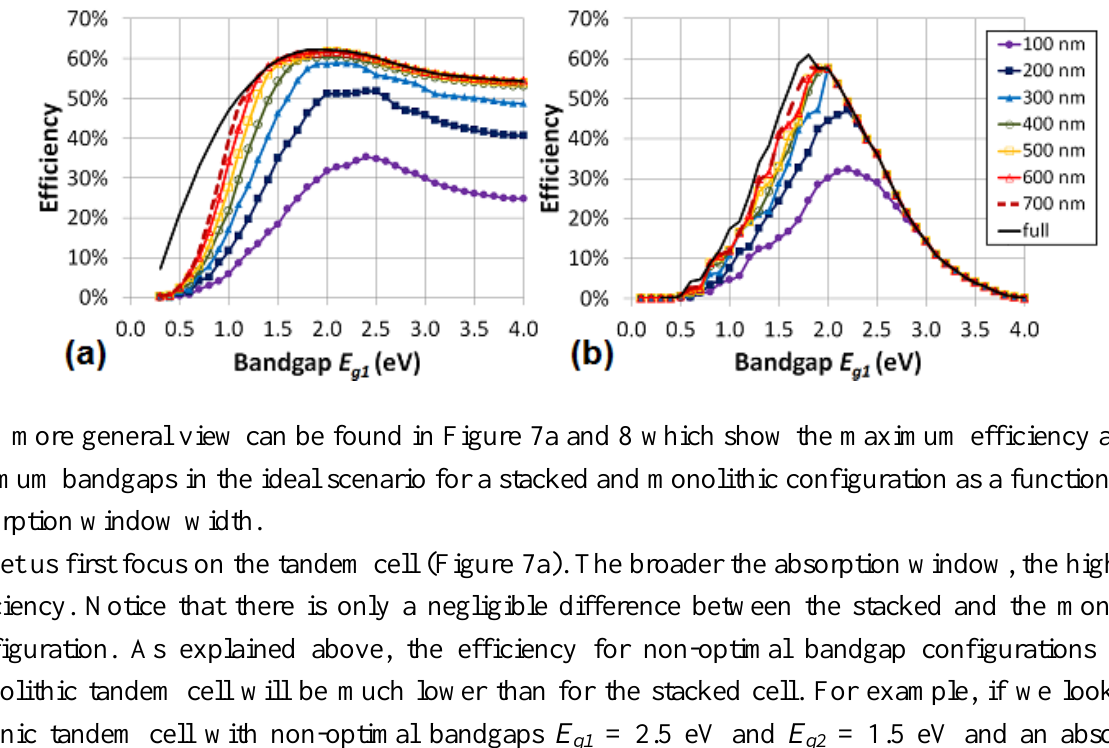
, optimal chosen bandgaps g1